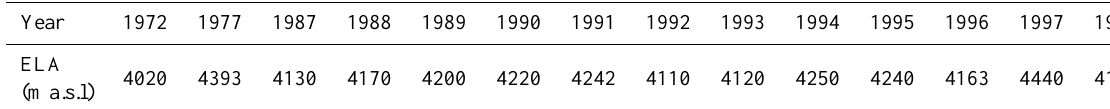
Table 3. ELA records of Abramov glacier (WGMS, 2001; Pertziger, 1996).